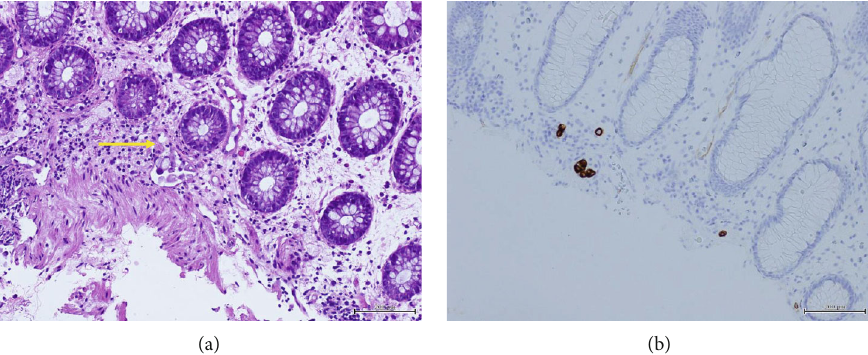
Figure 2: (a) Rectal biopsy showing signet ring cells (yellow arrow). (b) Rectal biopsy positive for cytokeratin 7